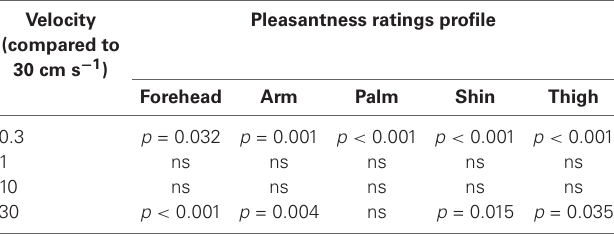
Table 2 | Significant differences between pleasantness ratings from stroking at 3 cm s − 1 compared to the other velocities, over all the skin sites